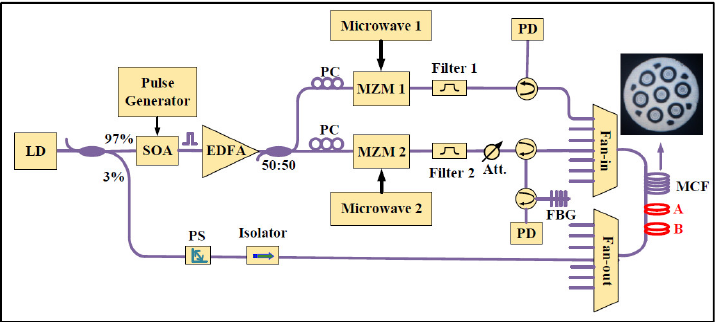
Figure 7. Experimental setup of the MCF based SDM hybrid BOTDA and Φ-OTDR system. (Reprinted/Adapted) with permission from [48] © The Optical Society.